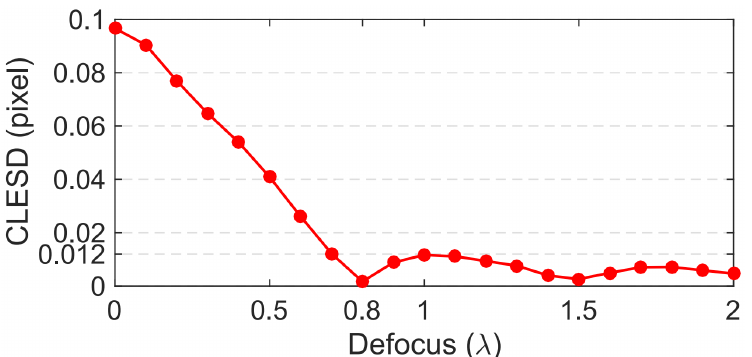
Figure 3. The relationship between defocus degrees of imaging spots and CLESD. When the defocus degree was 0.8 ( λ ) , the CLA was highest with a value of 0.002 pixels.